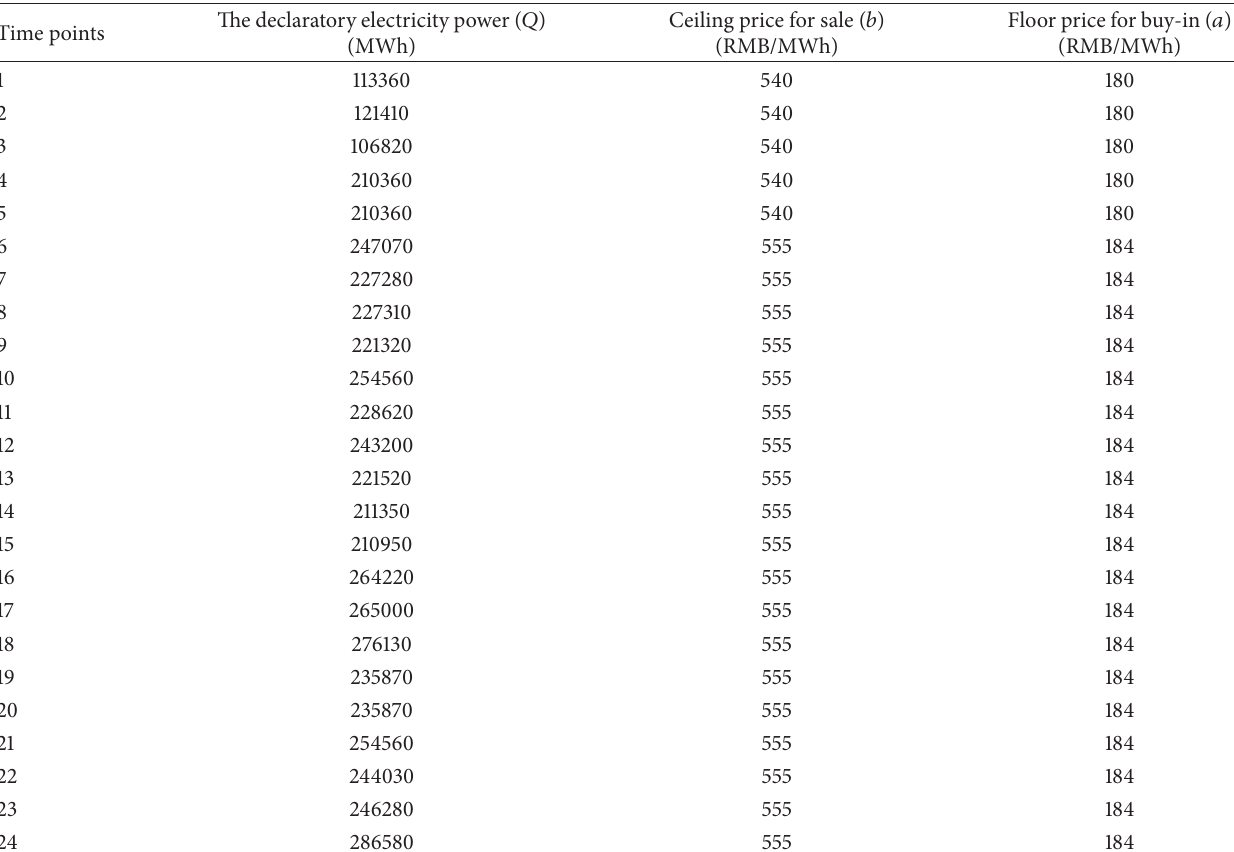
Table 2: The declaratory electricity power and limited